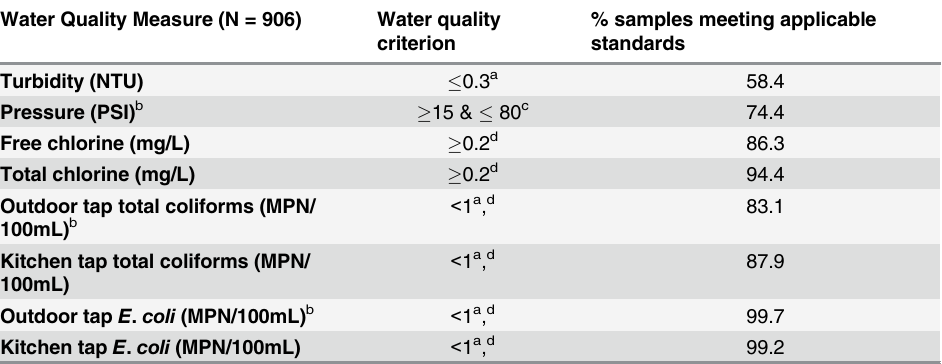
Table 2. Summary of Measured Water Quality from Households in a Cross-sectional Study on Water Supply and Health in Rural Alabama